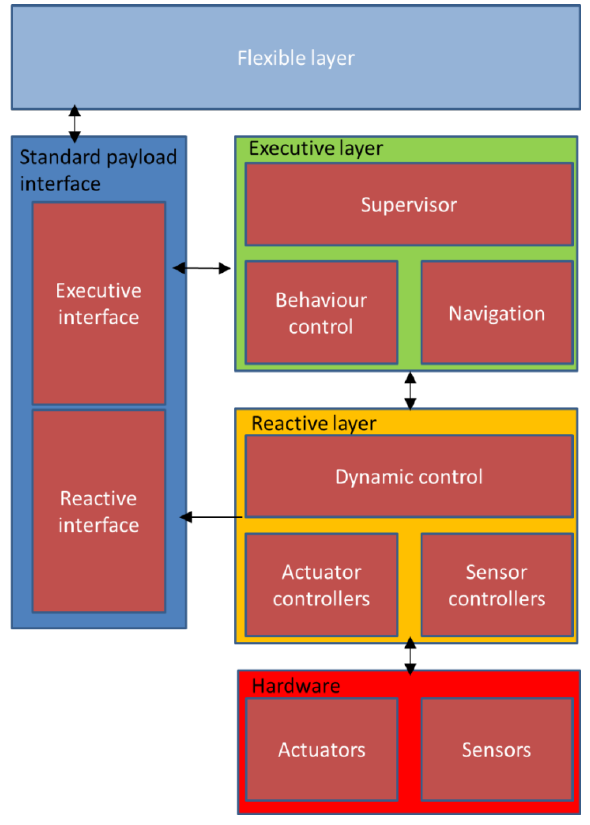
Figure 14. Huxley architecture, as described in [55].